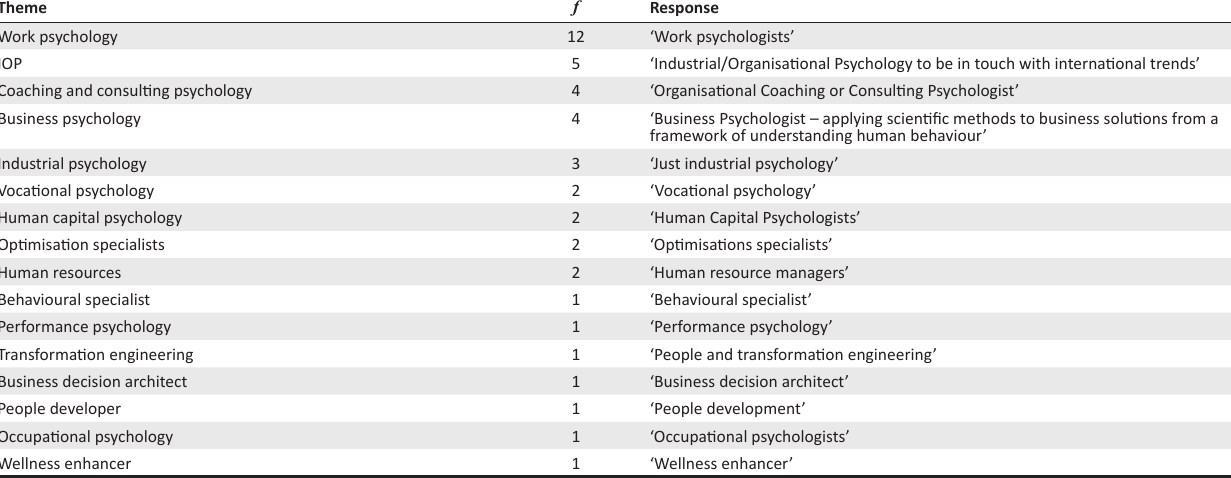
TABLE 4: Professional designation or label for